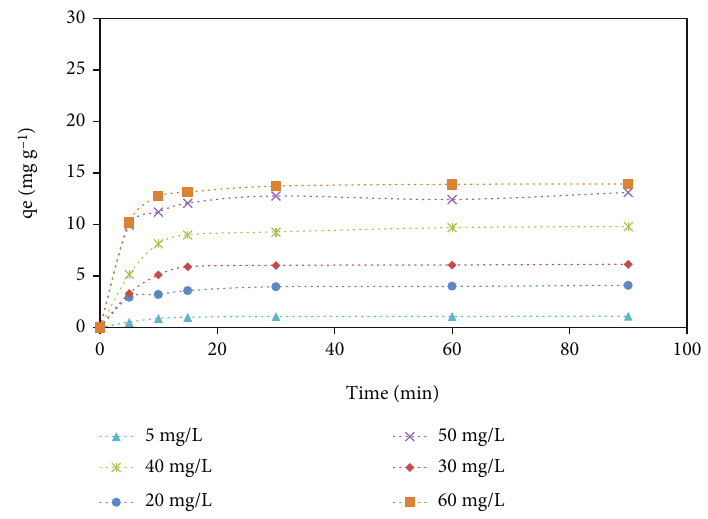
Figure 7: E ff ects of initial carmoisine concentration and contact time on adsorption e ffi ciency.